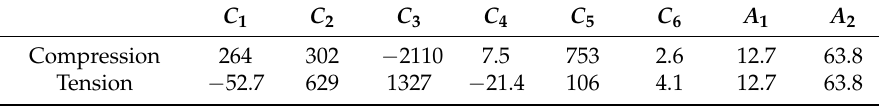
Table 1. Optimal parameter values determined by the least-square method.